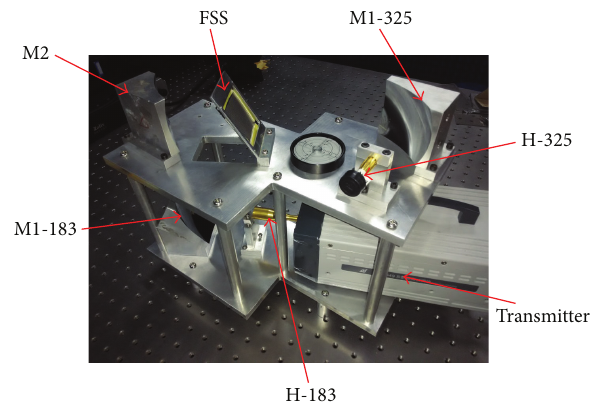
Figure 11: Prototype of 3D quasi-optical